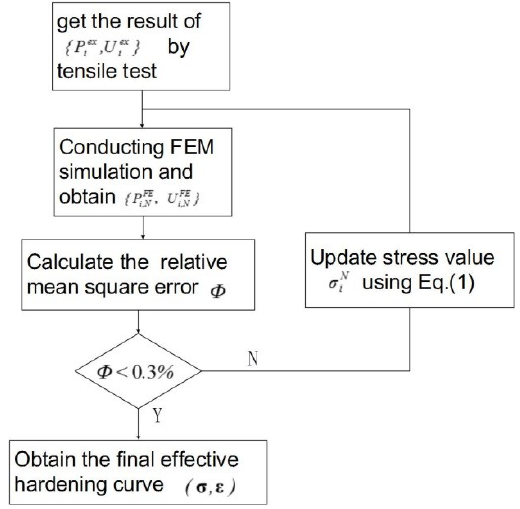
Figure 3. Schematic diagram of the inverse method.